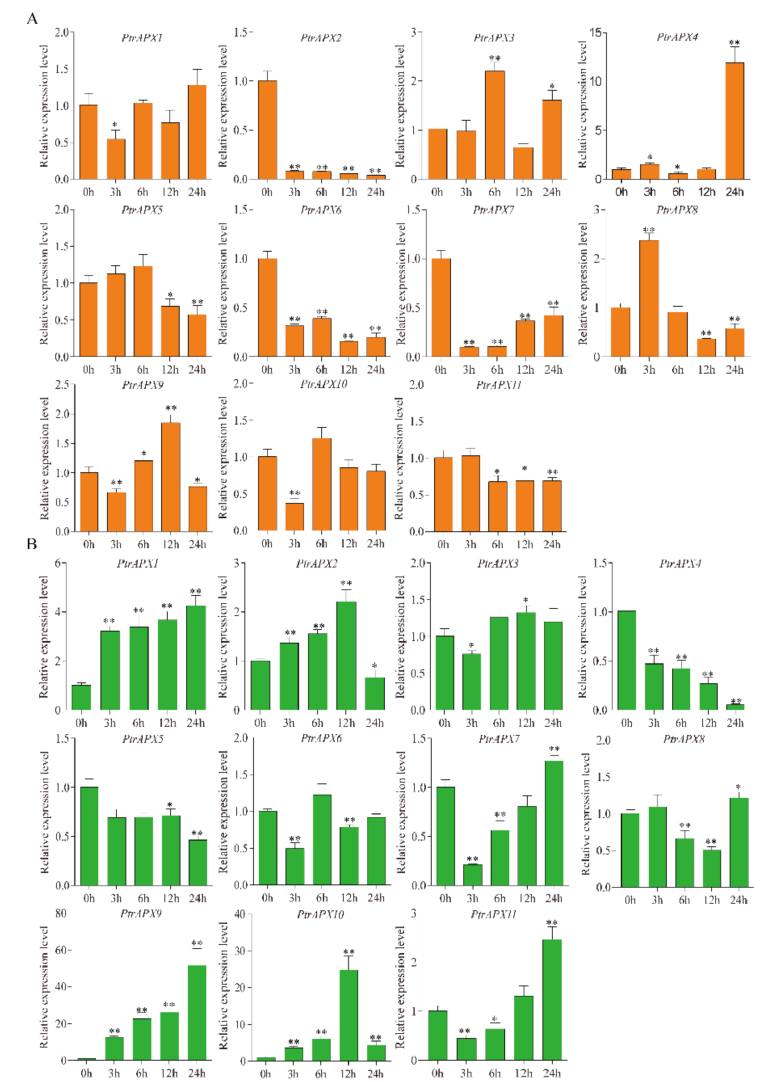
Figure 10. Relative expression level of PtrAPX genes under 200 µ M abscisic acid (ABA) treatment estimated by RT-qPCR. The expression pattern of PtrAPX genes in roots ( A ) and leaves ( B ) is shown. Error bars represent the standard deviations from three biological replicates. The x-axis represents time points after ABA treatment. Asterisks indicate stress treatment groups that showed a significant difference in transcript abundance compared with the control group (* 0.01< p < 0.05, ** p <